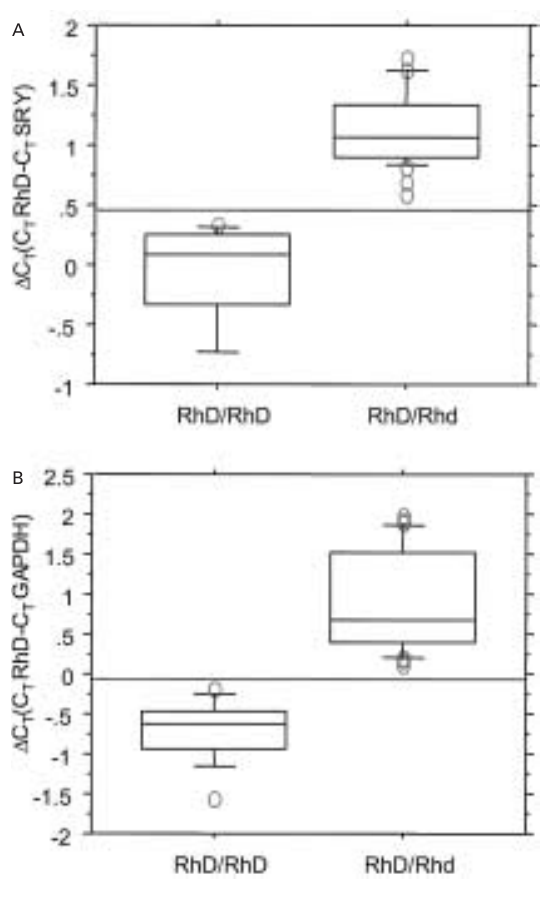
Box-plot showing the discernment of RHD zygosity by real-time PCR. In Figure 1A, the RHD gene has been examined in comparison with the SRY gene. In Figure 1B, the RHD gene has been examined in comparison with the GAPDH gene. The lines inside the boxes indicate the median value, whereas the upper and lower limits of the boxes represent the 75 th and 25 th percentiles respectively. The upper and lower horizontal bars indicate the 90 th and 10 th percentiles respectively. Outliers are indicated by open circles. The X axis indicates the RHD genotype de- termined, whereas the Y axis indicates the pertinent ∆ C T values. No overlap was observed between the two geno- typic groups. The cut-off values are indicated by stippled